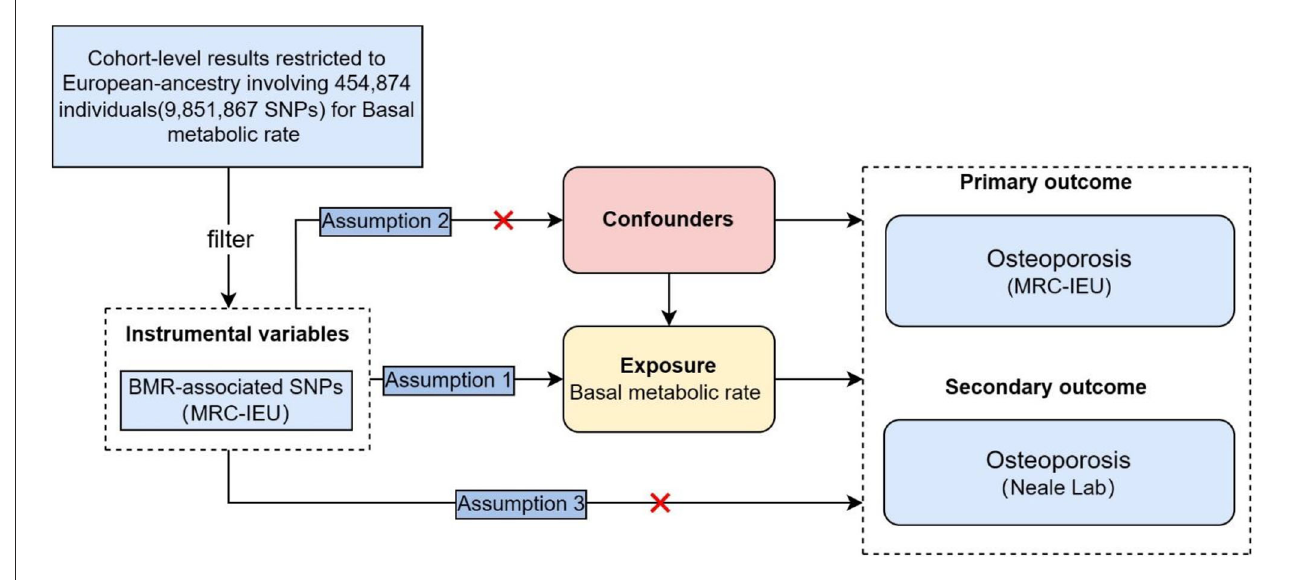
FIGURE1 Schematic representation of the study.